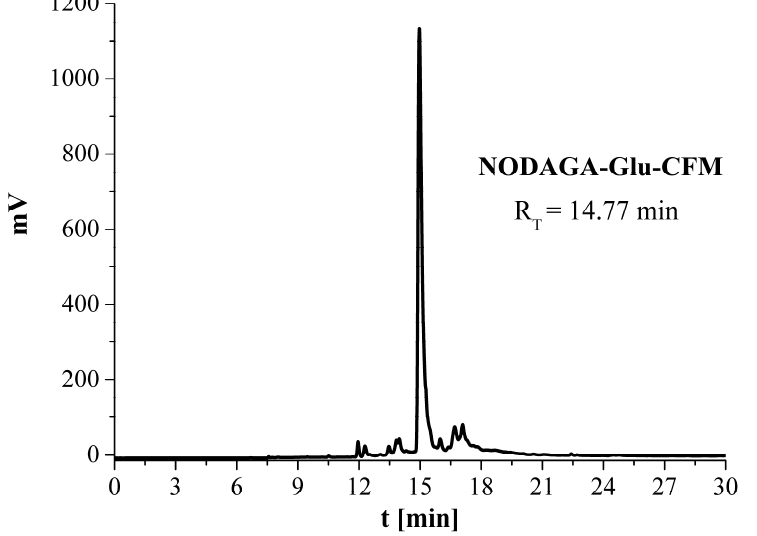
Figure 6. HPLC chromatogram recorded at 270 nm of the deprotection reaction of Boc-Glu-CFM in 2.5% TFA solution (gradient 2).